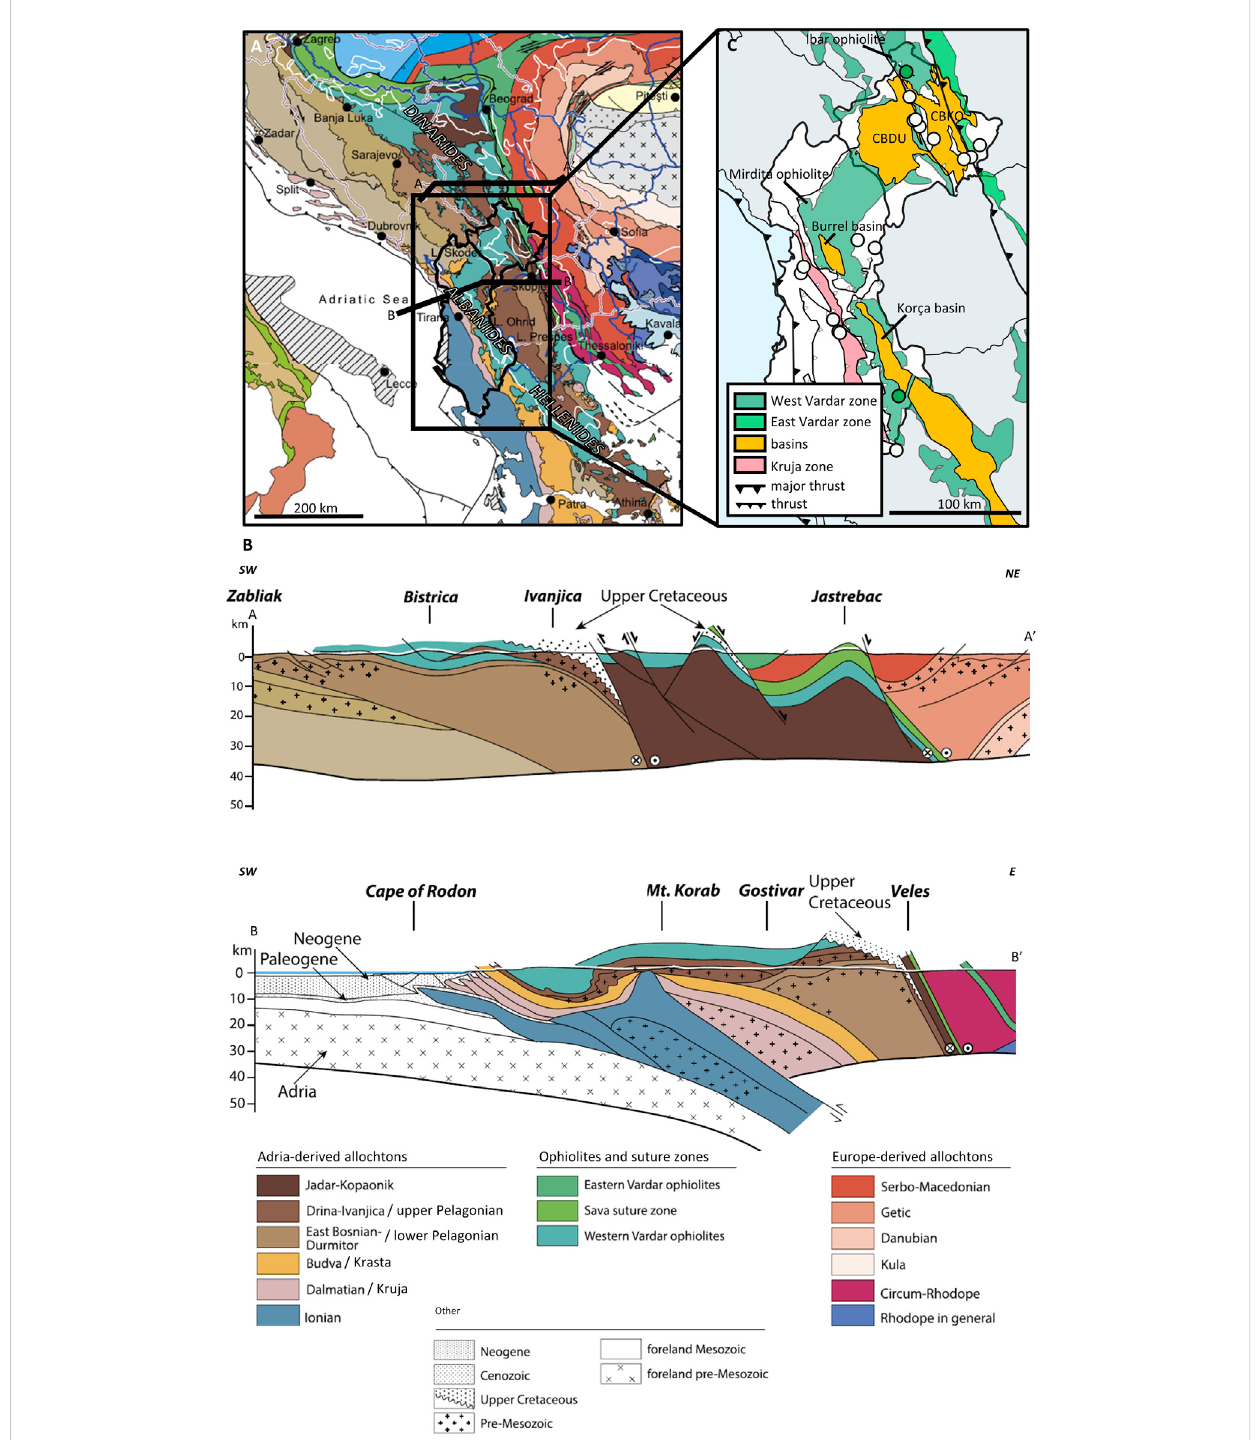
FIGURE 1 (A) Geological map of the Dinarides modi fi ed from Schmid et al. (2020) and (B) associated cross-sections A-A ′ and B-B ′ crosscutting West Vardar. (C) Simpli fi ed map of the zone of interest with the major structures related to the H basins, and the Kruja zone which is known as a geothermal area in Albania. The thrusts are also represented. CBDU, Cenozoic Basin of Dukagjin; CBDO, Cenozoic Basin of